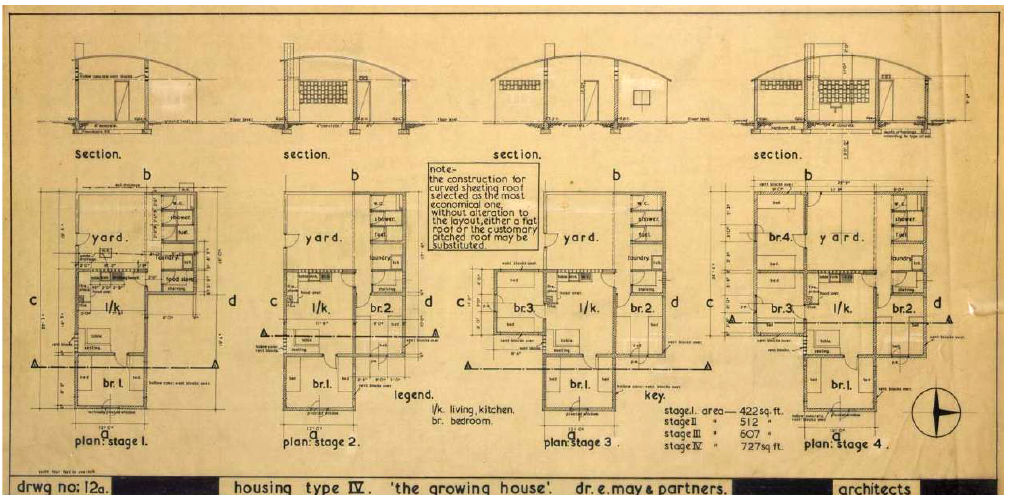
Figure 21. Rendering of the African Family Flats, the expandable single house, Satellite Port Tudor. Source: Herrel (2001). 2020 Settlement, the targeted echelons are not the low- est ones, so they become more analogous to the experi- ences of Römerstadt and Praunheim I and II rather than Praunheim III and Westhausen.